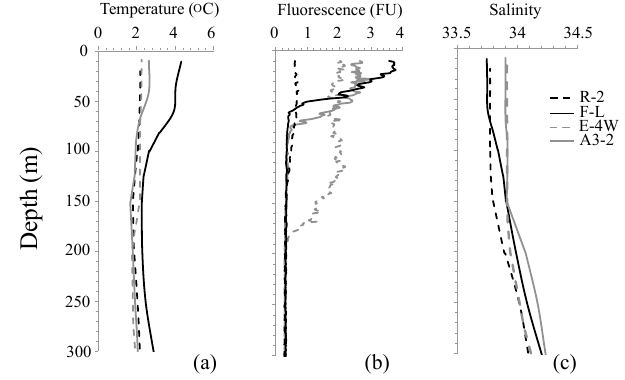
Figure 2. Profiles of temperature (a) , Chl a as derived from in vivo fluorescence (b) and salinity (c) for each of the four sampling sta-